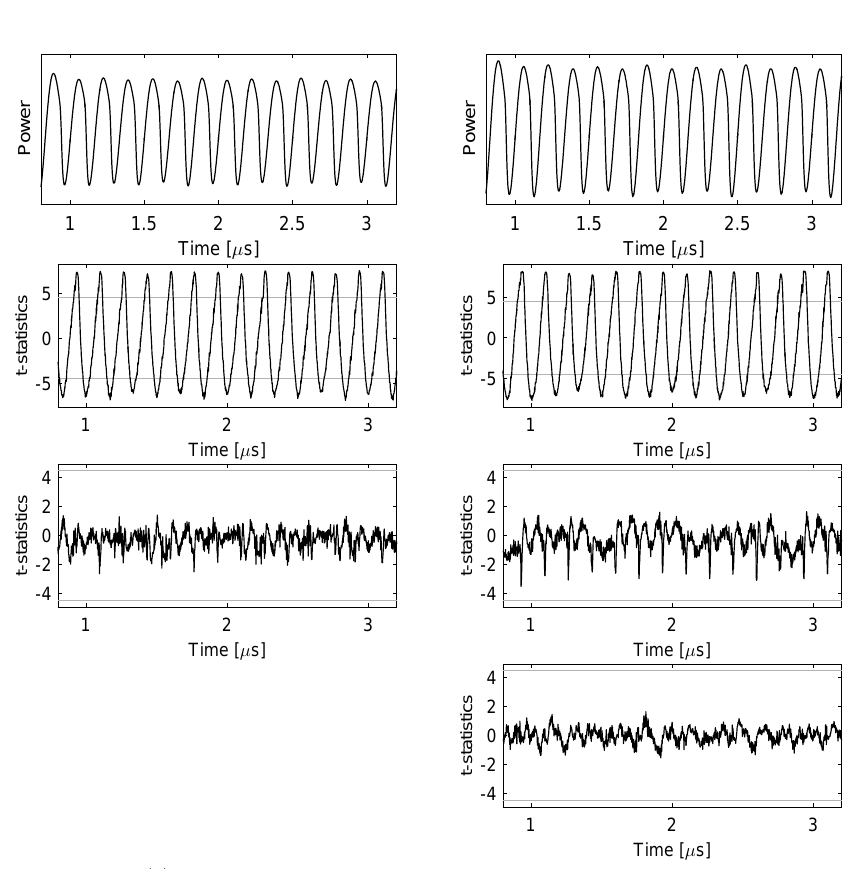
Figure 16: Case study 1: Vdd 1.3 v, shunt 0.0 Ω, 6 MC modules, clock 6 MHz, room temperature, (top) sample power trace, (2nd row) 1st-order t -test results, (3rd row) 2nd-order t -test results, (bottom) 3rd-order t -test results using 200 million